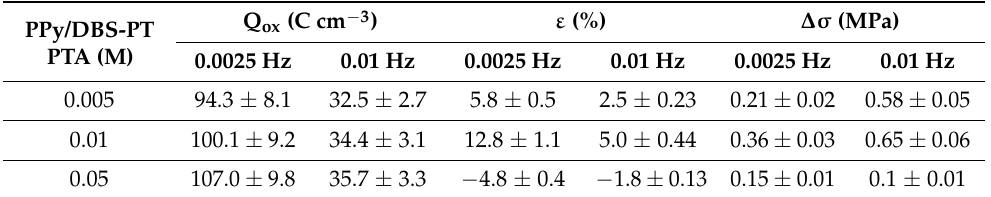
Table 2. PPy/DBS-PT films (different PTA concentrations), showing strain, ε , stress differences, ∆ σ , and charge density upon oxidation, Q ox , at frequencies of 0.0025 and 0.01